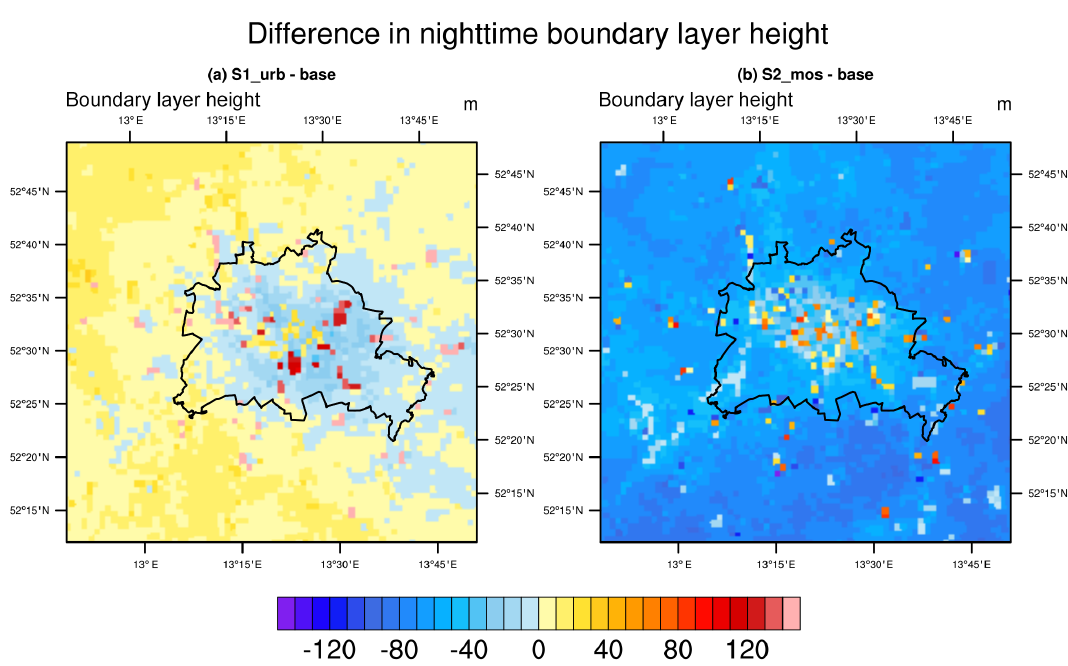
Figure 13. Differences in nighttime (20:00–02:00UTC) mean JJA planetary boundary layer height as diagnosed from WRF-Chem, (a) S1_urb – base run, (b) S2_mos – base run (at 1km horizontal